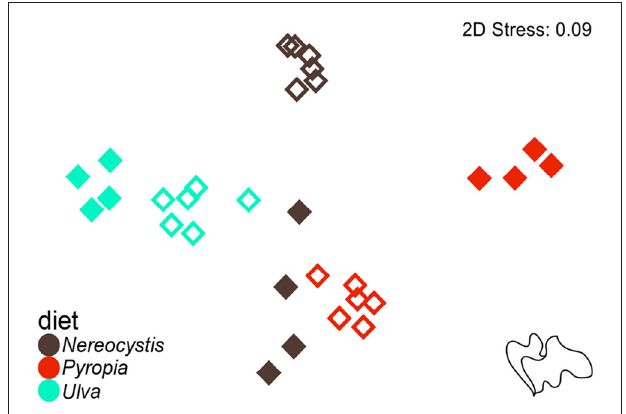
FIGURE 2 | Non-metric multidimensional scaling (nMDS) plot of Euclidean distances between the proportions of FA ( n = 37) of macroalgal monoculture diets ( Nereocystis, Pyropia, or Ulva ) fed to S. droebachiensis (filled symbols) and S. purpuratus (open symbols).